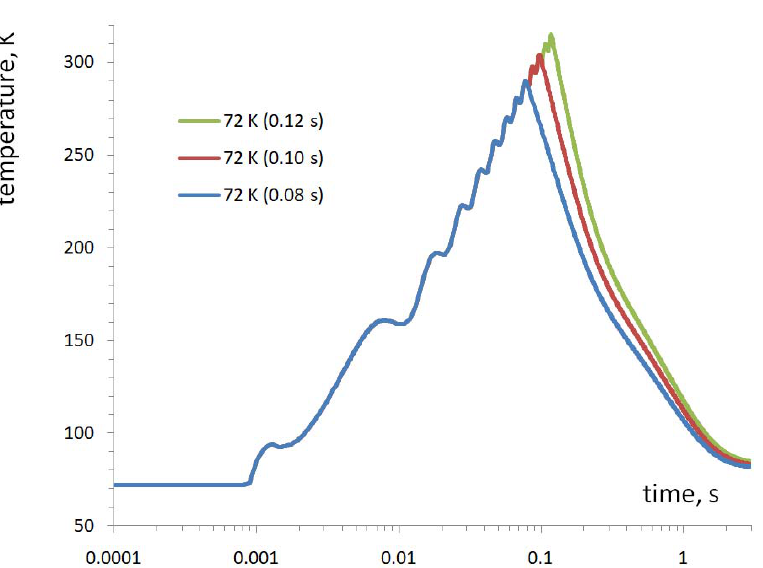
Figure 12. Changes in temperature of the limiter HTS tape during short circuit (0–0.08 s) and cooling (0.08–3 s)—“72 K (0.08 s)” and during short circuit (0–0.1 s) and cooling (0.1–3 s)—“72 K (0.1 s)” and during short-circuit (0–0.12 s) and cooling (0.12–3 s)—“72 K (0.12 s)” for the initial temperature of the limiter before short-circuit = 72 K.